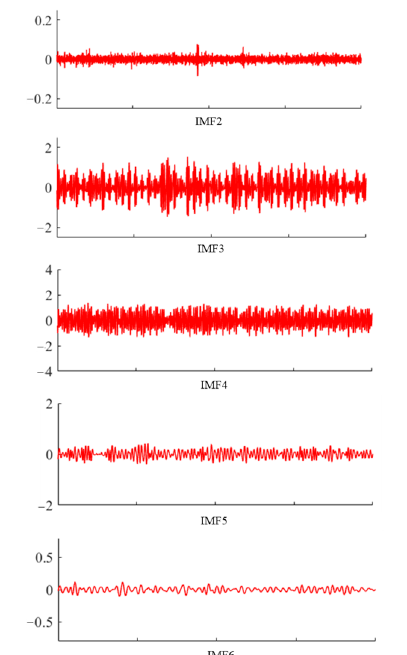
Figure 5. Time domain waveform of vibration signal of main pump in main pump normal state.